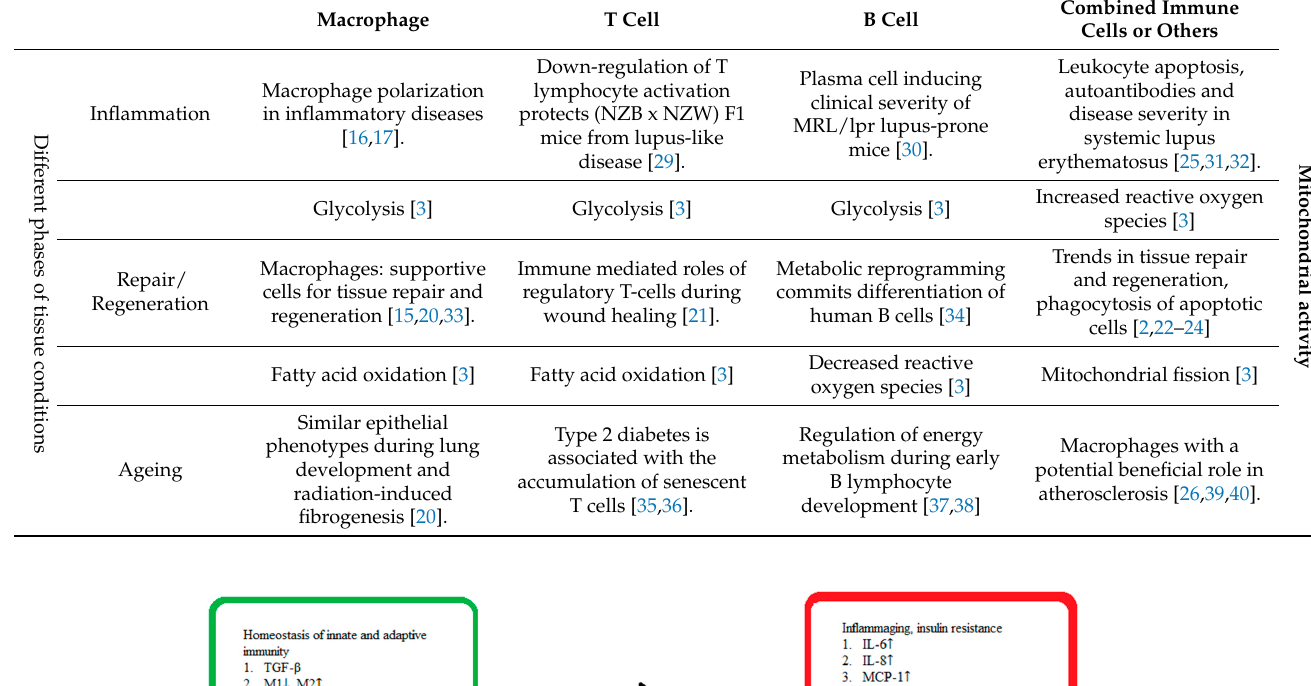
Table 1. Summary of the immune cells or other cells/molecules in different states of mitochondrial condition in this review article.